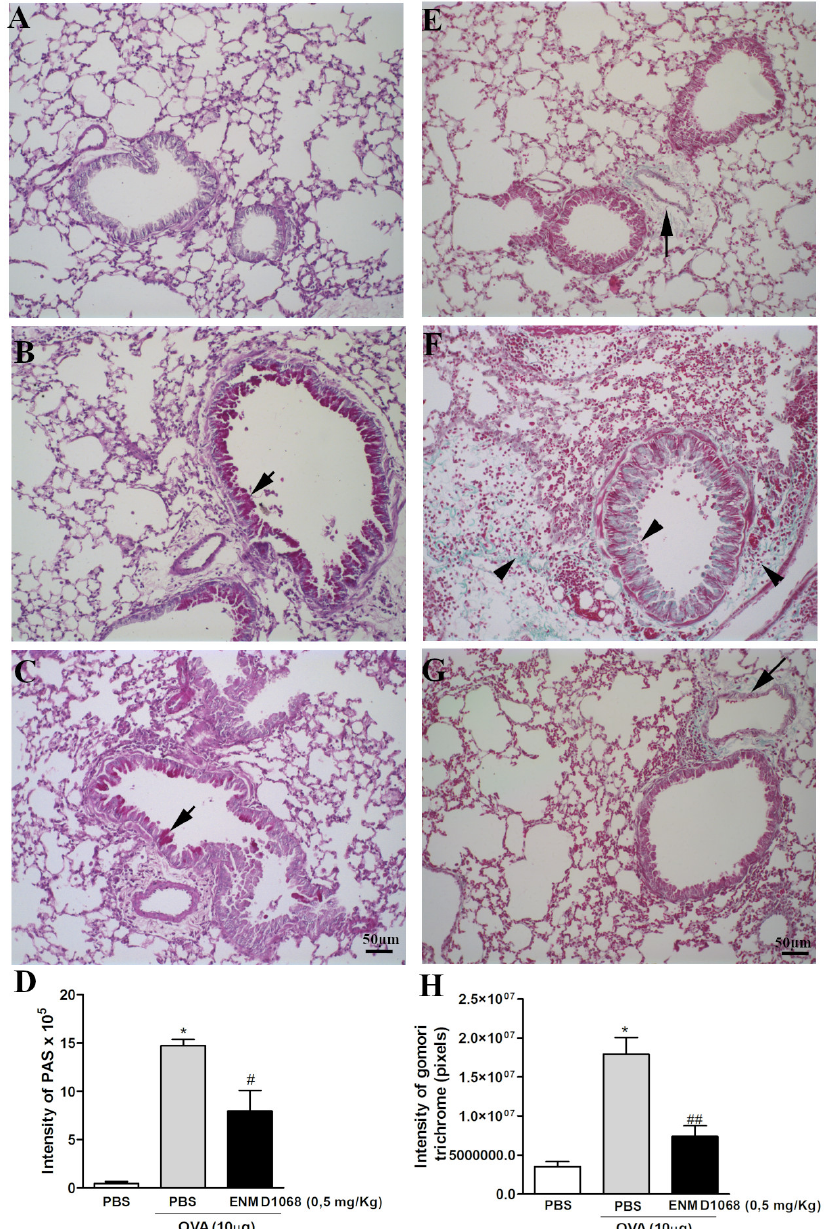
FIGURE 4 - Effects of PAR2 peptide antagonist ENMD1068 treatment on mucus and collagen production in the lungs of sensitized mice by multiple exposures to OVA. Representative histological sections of lungs of mice 48 hours after the last intranasal allergen challenge. Ovalbumin-sensitized mice were instilled with PBS (A, E), OVA (B, F) or pretreated with ENMD1068 1 h before intranasal instillation of OVA (C, G).Lungs stained by PAS, black arrows show vesicles releasing mucous and mucous accumulation in the lung parenchyma (A-C).Lungs stained by Gomori Trichrome, black arrow points show collagen deposition in the bronchial epithelium and lung parenchyma (E-G).PAS (D) and Gomori Trichrome (H) staining in lung tissue. The results are representative of 2 independent experiments and are expressed as the mean ± SEM of 6-8 mice/group. *p<0.001 compared to the PBS group, # p<0.05 ## p<0.001 ENMD1068 group when compared to OVA group (one-way ANOVA /